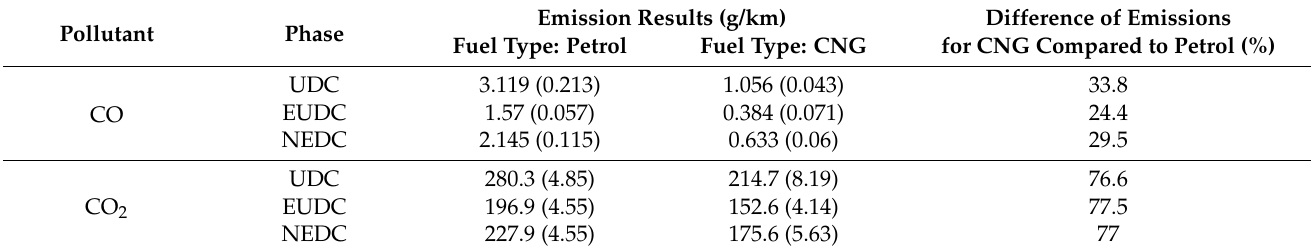
Table 5. Average emission results for New European Driving Cycle (NEDC) test (standard deviation values are given in